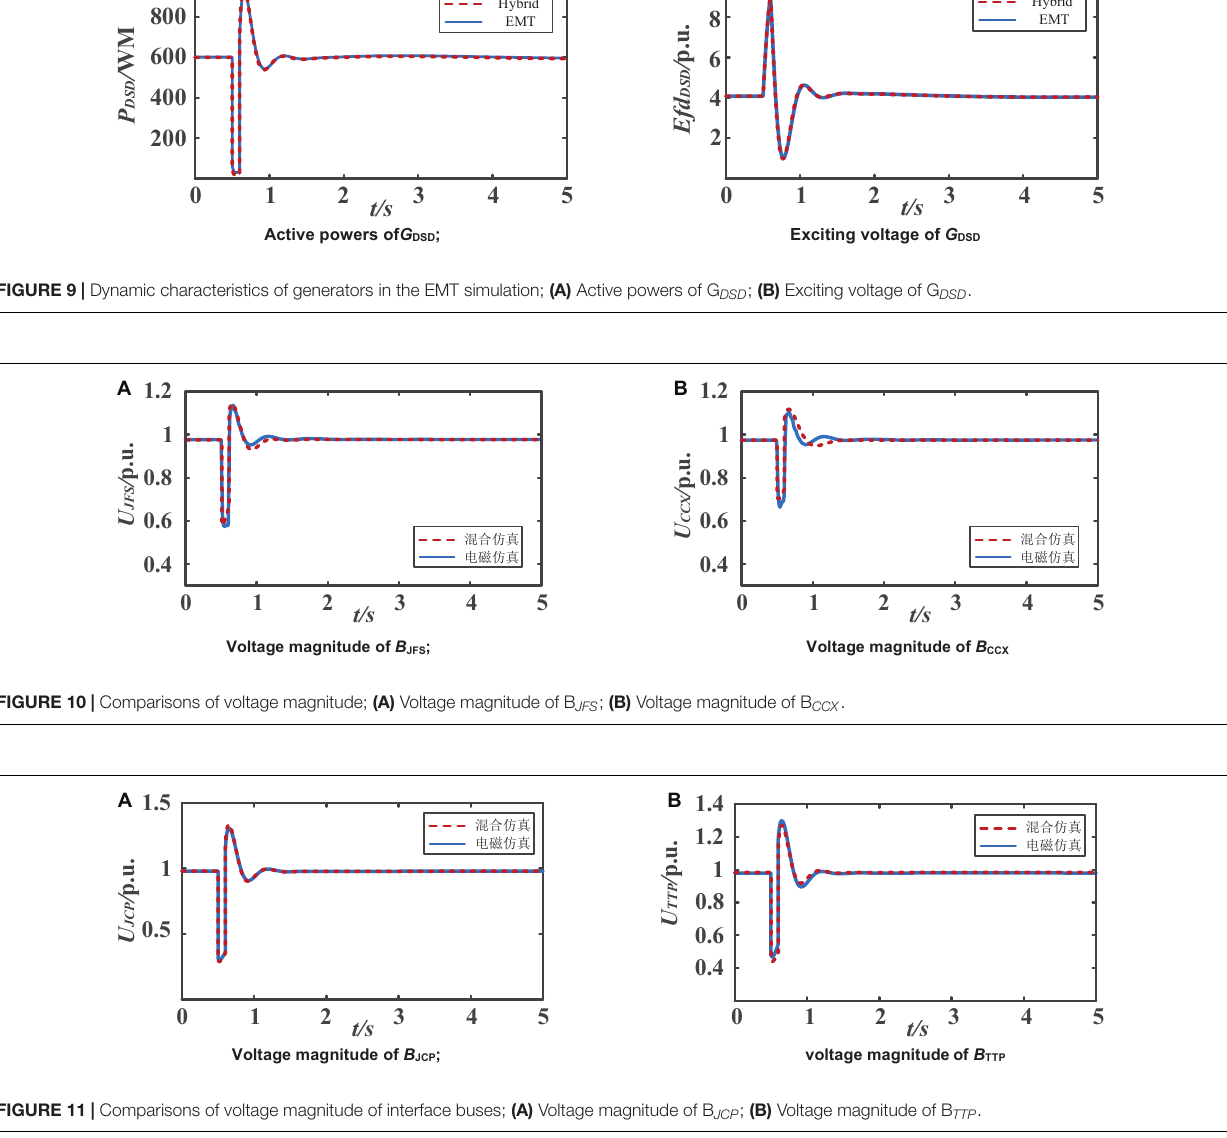
Frontiers in Energy Research |